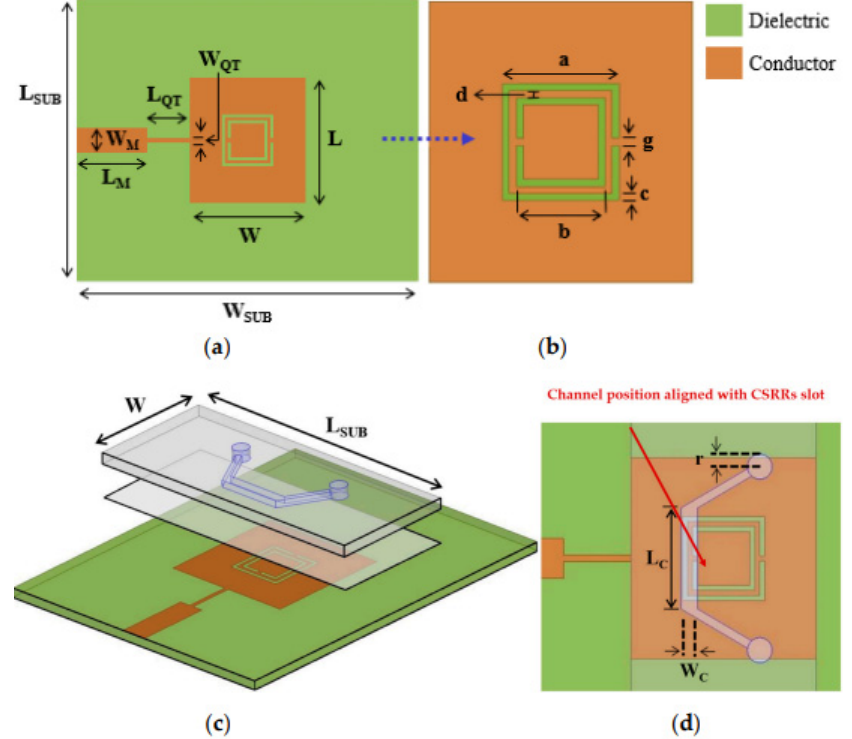
Figure 30. ( a ) Top view of CSRR-loaded patch fed by quarter-wave stub and microstrip line before loading PDMS; ( b ) zoom-in image of the CSRRs slot; ( c ) bird’s-eye view of the proposed sensor with the microfluidic channel; ( d ) top view of channel alignment with CSRRs slot [78]. Gas-sensing devices are becoming increasingly used in a variety of settings, includ- ing interior spaces, industries, aircraft, and detectors for numerous harmful household gases and vapors [79]. Several distinct fluid/gas flows must be monitored for industrial applications since the flow of the fluid might affect the product under production. As a result, precise measurement is required to produce a high-quality product at the conclusion of the manufacturing process. Gas sensors are mostly employed in the petrochemical industry in the industrial world. Some carbon dioxide sensors, ammonia sensors, nitric oxide sensors, and other sensors can be used in specialized applications to detect carbon dioxide, ammonia, chlorine, and other dangerous gases [80]. The interaction between typi- cal aroma composing components and the response of semiconducting gas sensors and one microgravimetric sensor is presented using some fundamental concepts [81]. The selection of sensor materials to manage baking and roasting operations has been based on several broad principles. Using a basic electronic nose with two to four oxide sensor components, important aroma molecules, such as 2-acetyl-1-pyrroline (typical pop-corn scent), were demonstrated to affect the toasting of white bread (no pre-selection by a chromatographic column necessary). Other uses, such as controlling meat roasting, will continue to be problems in the future. Sensor components that are sensitive to sup-ppm levels, as well as particular to key scent constituents, are needed. Finally, packaging, transportation, and aging of items during storage or usage can all affect flavor; some of these factors are covered in the work of [82]. Table 5 summarize the parameters comparison between different microfluidic